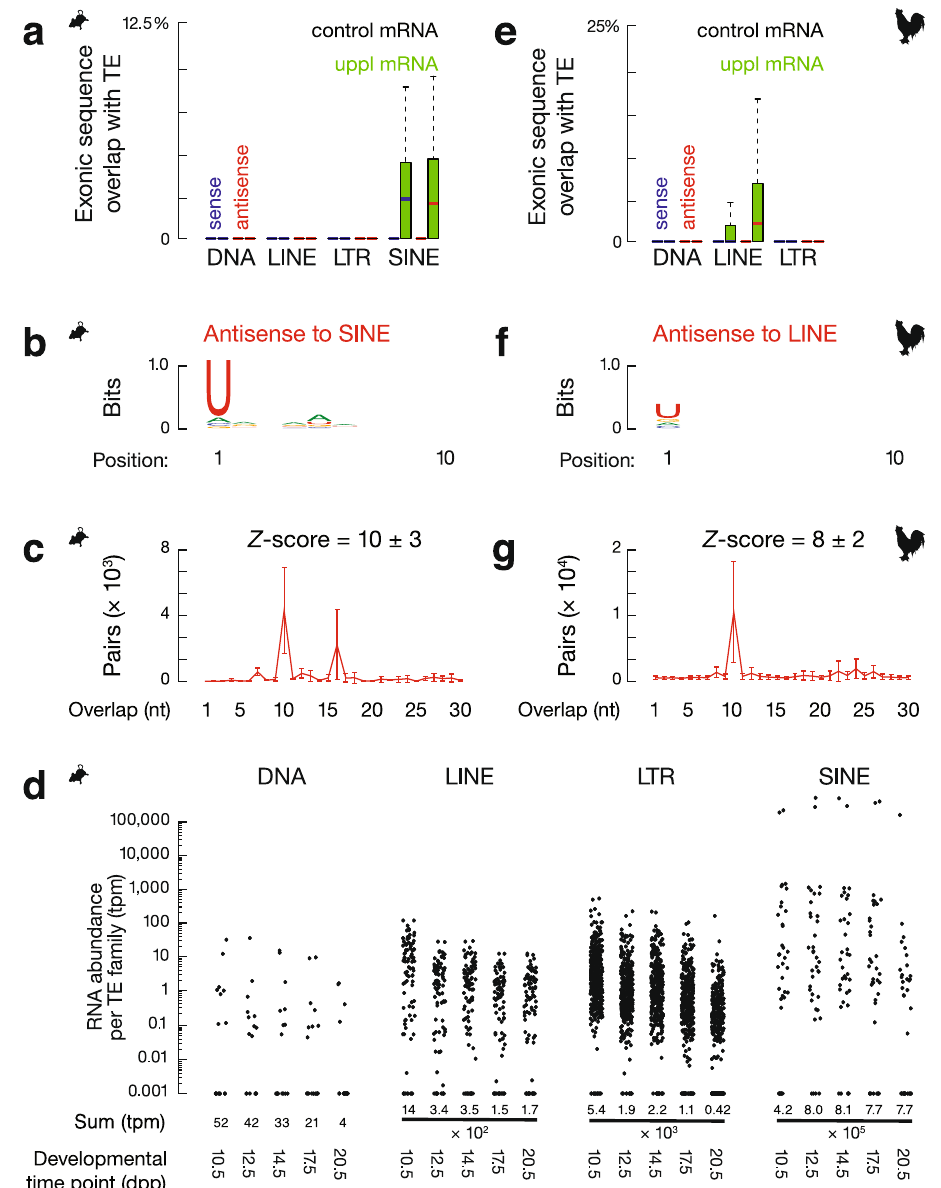
Fig. 7 Spliced piRNA precursor mRNAs contain transposon fragments. a Boxplots showing the fraction of transcript exon sequence correspondence to sense (blue) and antisense (red) transposon sequences in mouse genome. Control mRNA n = 43, uppl mRNA n = 30. b Sequence logo showing the nucleotide composition of antisense SINE-piRNA species that uniquely map to mouse uppl mRNAs. c The 5 ′ – 5 ′ overlap between piRNAs from opposite strands of SINE consensus sequences was analyzed to determine whether antisense SINE piRNAs from mouse uppl mRNAs display Ping-Pong ampli fi cation in trans. The number of pairs of piRNA reads at each position is reported (sample size n = 3 independent biological replicates). Data are mean ± standard deviation. The Z score indicates that a signi fi cant ten-nucleotide overlap (Ping-Pong) was detected. Z score = 1.96 corresponds to p value = 0.025. d The RNA abundance of each TE superfamily in testes at the fi ve developmental time points. Dpp: days postpartum, tpm: transcript per million. e Boxplots showing the fraction of transcript exon sequence correspondence to sense (blue) and antisense (red) transposon sequences in chicken genome. Control mRNA n = 23, uppl mRNA n = 23. f Sequence logo showing the nucleotide composition of antisense LINE-piRNA species that uniquely map to chicken uppl mRNAs. g The 5 ′ – 5 ′ overlap between piRNAs from opposite strands of LINE consensus sequences was analyzed to determine whether antisense LINE-piRNAs from chicken uppl mRNAs display Ping-Pong ampli fi cation in trans (sample size n = 3 independent biological replicates). Data are mean ± standard deviation. Z score = 1.96 corresponds to p value = 0.025. Box plots in a , e show the 25th and 75th percentiles, whiskers represent the 5th and 95th percentiles, and midlines show median